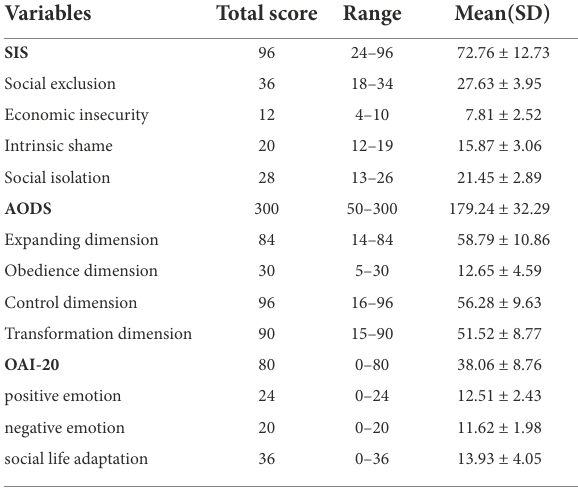
TABLE 3 The comparison of SIS, AODS and OAI-20 score ( N =